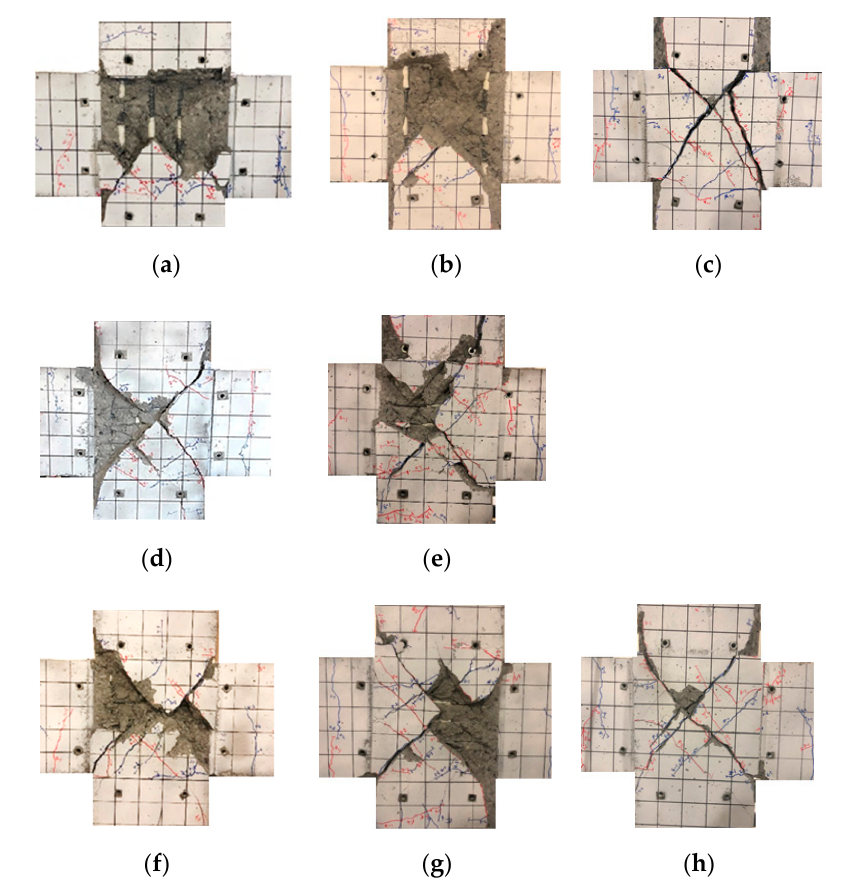
Figure 9. Failure modes at the end of the test: ( a ) S16-N; ( b ) S13-N; ( c ) U13-N; ( d ) S16-32; ( e ) S13-32; ( f ) S16-34; ( g ) S13-34; ( h ) U13-34.